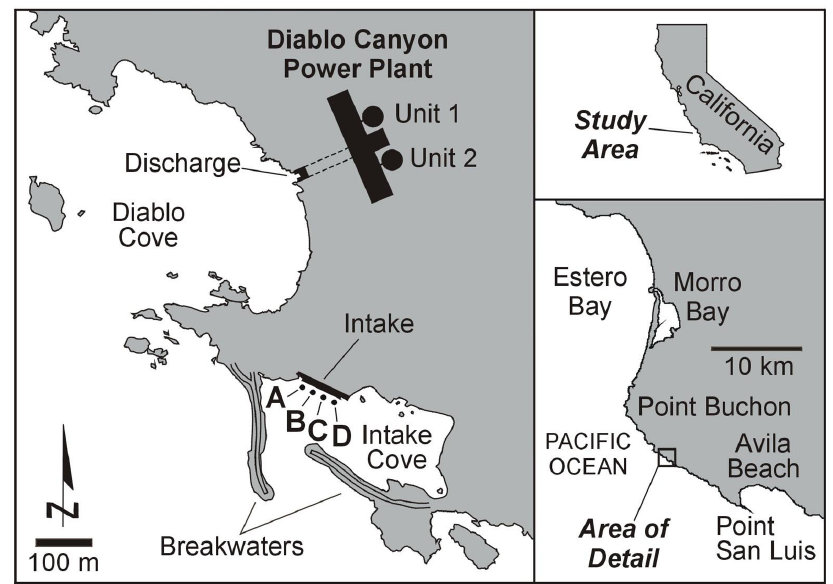
FIGURE 1. Diablo Canyon Power Plant, intake cove, and entrainment sampling locations (A, B, C, and